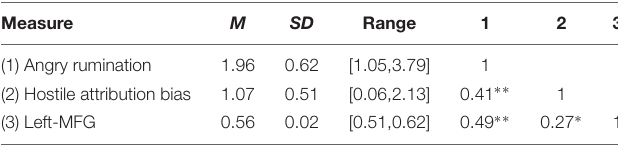
Region of Interest Definition